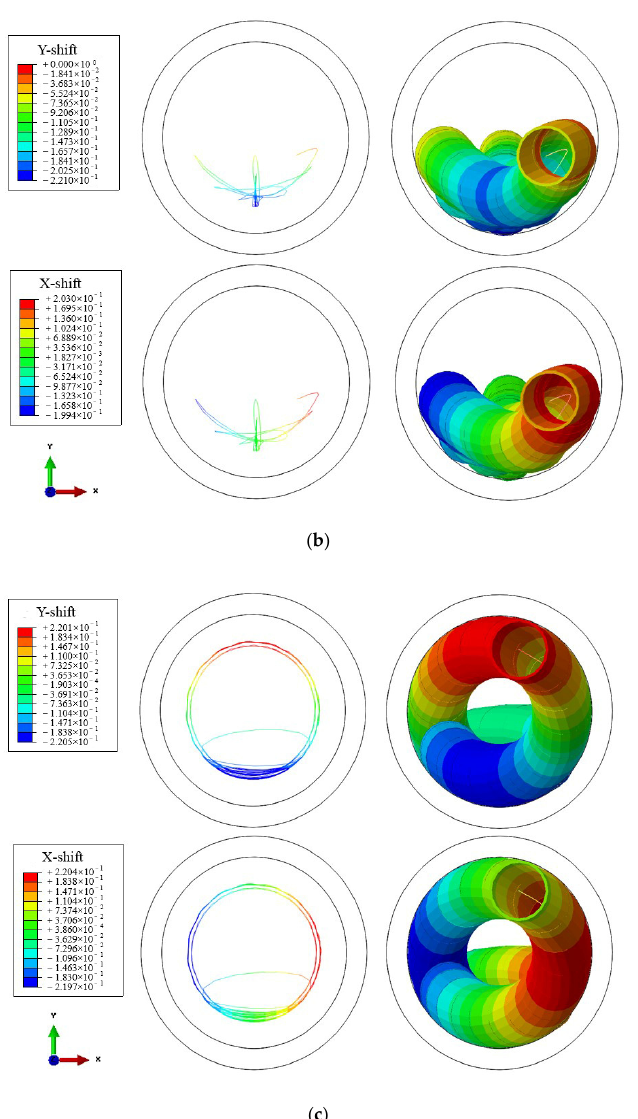
Figure 10. Three degrees of DS deformation (Unit: m). ( a ) The DS did not buckle. ( b ) The DS showed sinusoidal buckling. ( c ) The DS showed helical buckling.